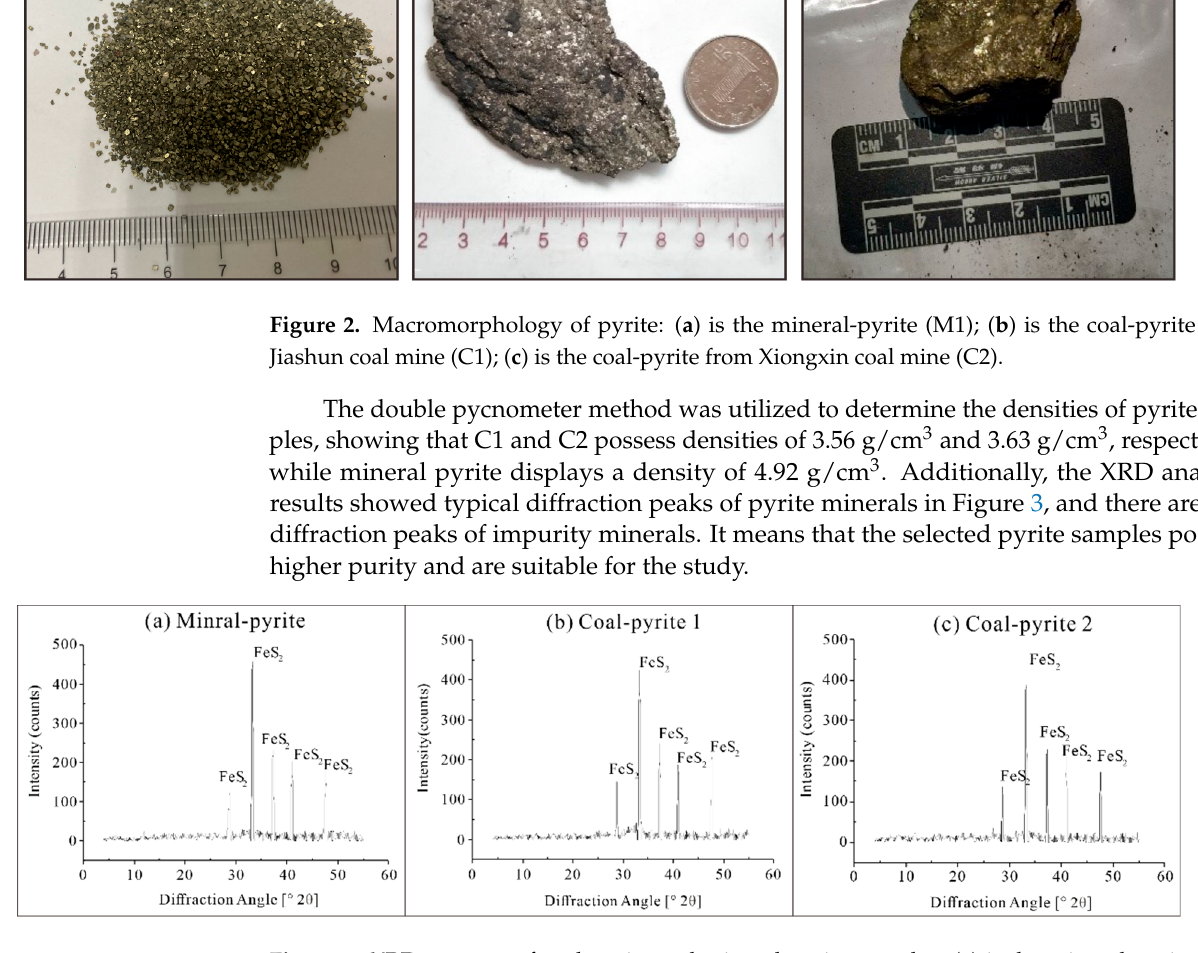
Figure 4. Occurrence forms of pyrite in coal samples: ( a ) is the framboidal pyrite (site 1); ( b ) is the fissure-filled (site 2) and aggregated massive pyrite (site 3); ( c ) is the euhedral crystalline pyrite (site 4); ( d ) is the caviar-like pyrite (site 5); ( e ) is the Fine-grained agglomerated pyrite (site 6); ( f ) is the aggregated massive pyrite (site 7); ( g ) is the euhedral crystalline pyrite (site 8). Among them, framboidal pyrites are aggregates of pyrite spheres (Figure 4a) that commonly occur in groups. Filled pyrite is the most prevalent type observed in coals and typically appears in banded (Figure 4b), dendritic, or reticulated patterns. The surface of the agglomerated massive pyrite presents pores and contains organic matter or minerals (Figure 4b), and some are formed by the bonding of fine-grained pyrite particles (Figure 4f). The intact crystal facets of euhedral crystalline pyrites exhibit triangular, square, rhombic, pentagonal, hexagonal, etc. (Figure 4c,g), and are often associated with clay min- erals. Caviar-like pyrite has a crystal shape that is densely piled up in groups (Figure 4d) or intermittently distributed along layers in a beaded form. The shape of fine-grained ag- glomerated pyrite (Figure 4e) appears irregular with uneven edges, semi-colloidal, having a porous surface, and is filled with clay minerals. The fresh pyrite section displays strong chemical activity and is susceptible to oxidi- zation. Pyrite in coal bodies can be mixed with clay minerals and organic matter, which further affects its properties. The element contents on the pyrite surface were tested by the